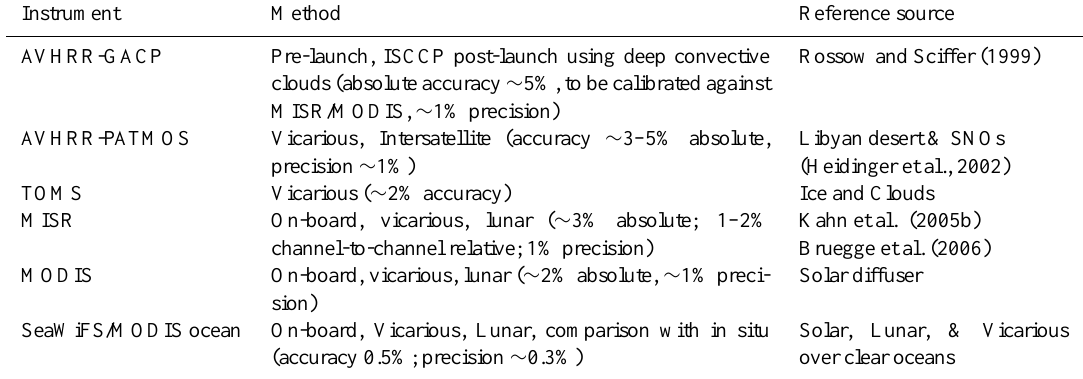
Table 1. Summary of the calibration approach, accuracy, and precision of existing satellite aerosol instruments.